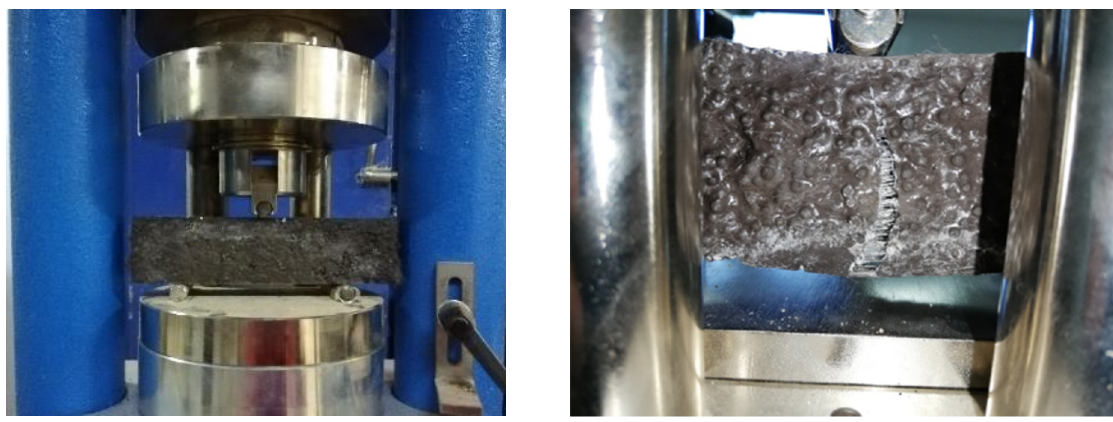
Figure 7. Fiber-reinforced specimen under flexural strength testing.